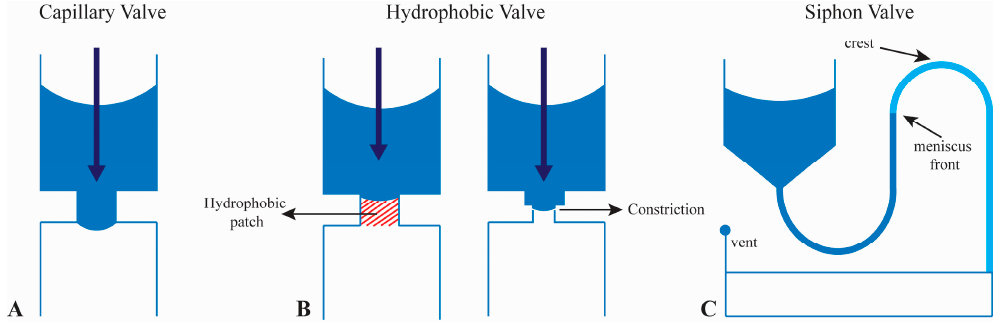
Figure 2. ( A ) Schematic of a capillary valve; ( B ) Schematic of hydrophobic valves using a hydrophobic patch or abrupt change in geometry; ( C ) Schematic showing a siphon valve where the siphon crest is located closer to the center of the CD than the meniscus front in the siphon microchannel. See text for details on the principles governing their function. Figure reprinted with permission of Royal Society of Chemistry [21].